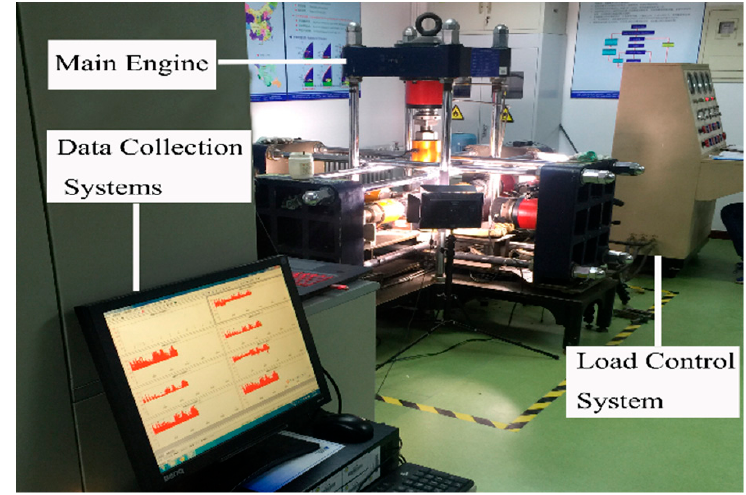
Figure 2. The rockburst physical simulation system.